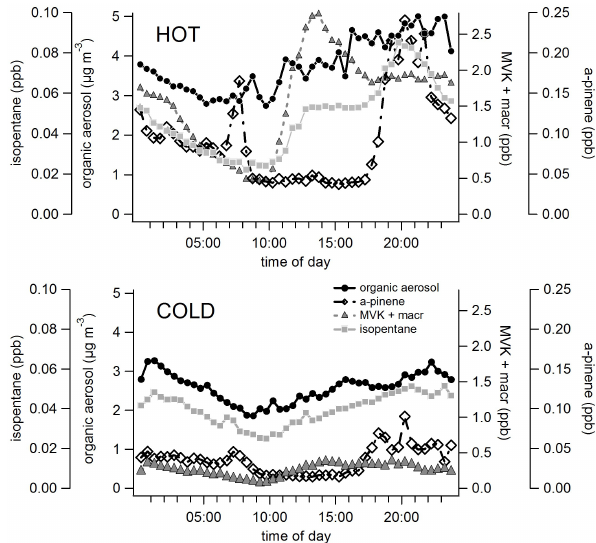
Fig. 4. Comparison of the diurnal variation of organic aerosol (OA), sum of methyl vinyl ketone and methacrolein (MVK+MACR), α - pinene and isopentane, separated into the two meteorological peri- ods; hot (top panel) and cold (bottom panel).